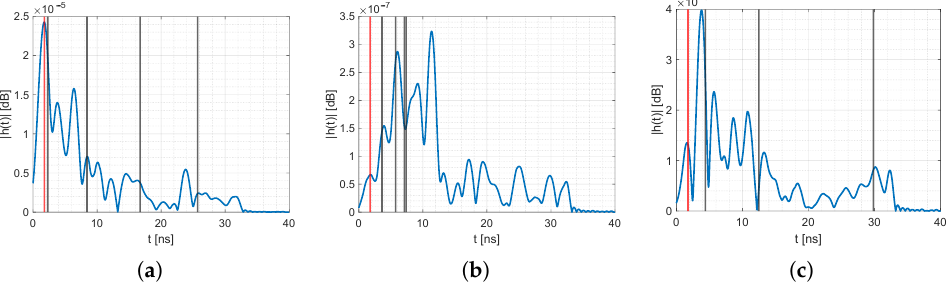
Figure 11. Idle CIRs for different sensor pairs. ( a ) CIR with MPCs from (1,2). ( b ) CIR with MPCs from (1,3). ( c ) CIR with MPCs from